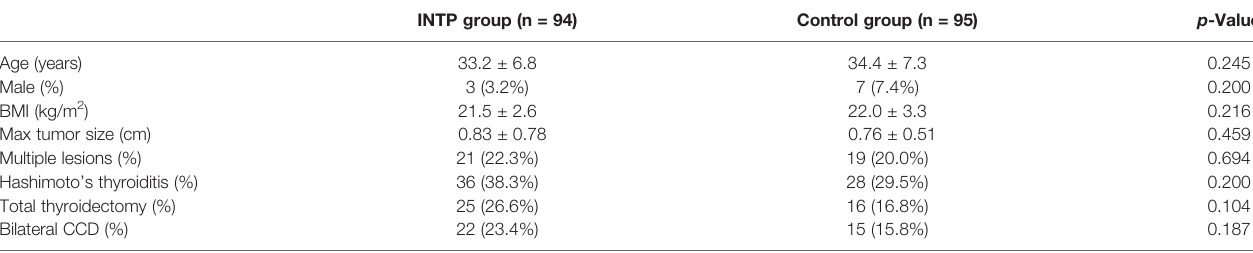
TABLE 2 | Clinicopathologic characteristics in trans breast endoscopic thyroidectomy.